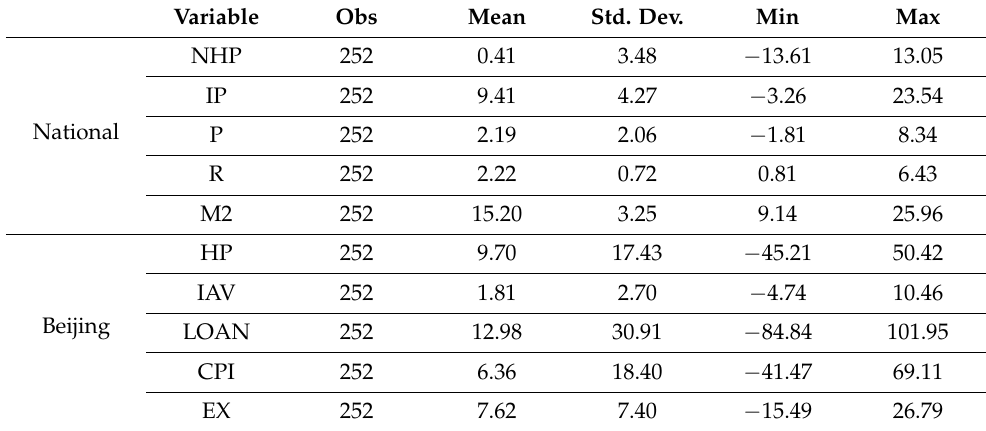
Table 4. Summary statistics of the growth rates of variables (part of